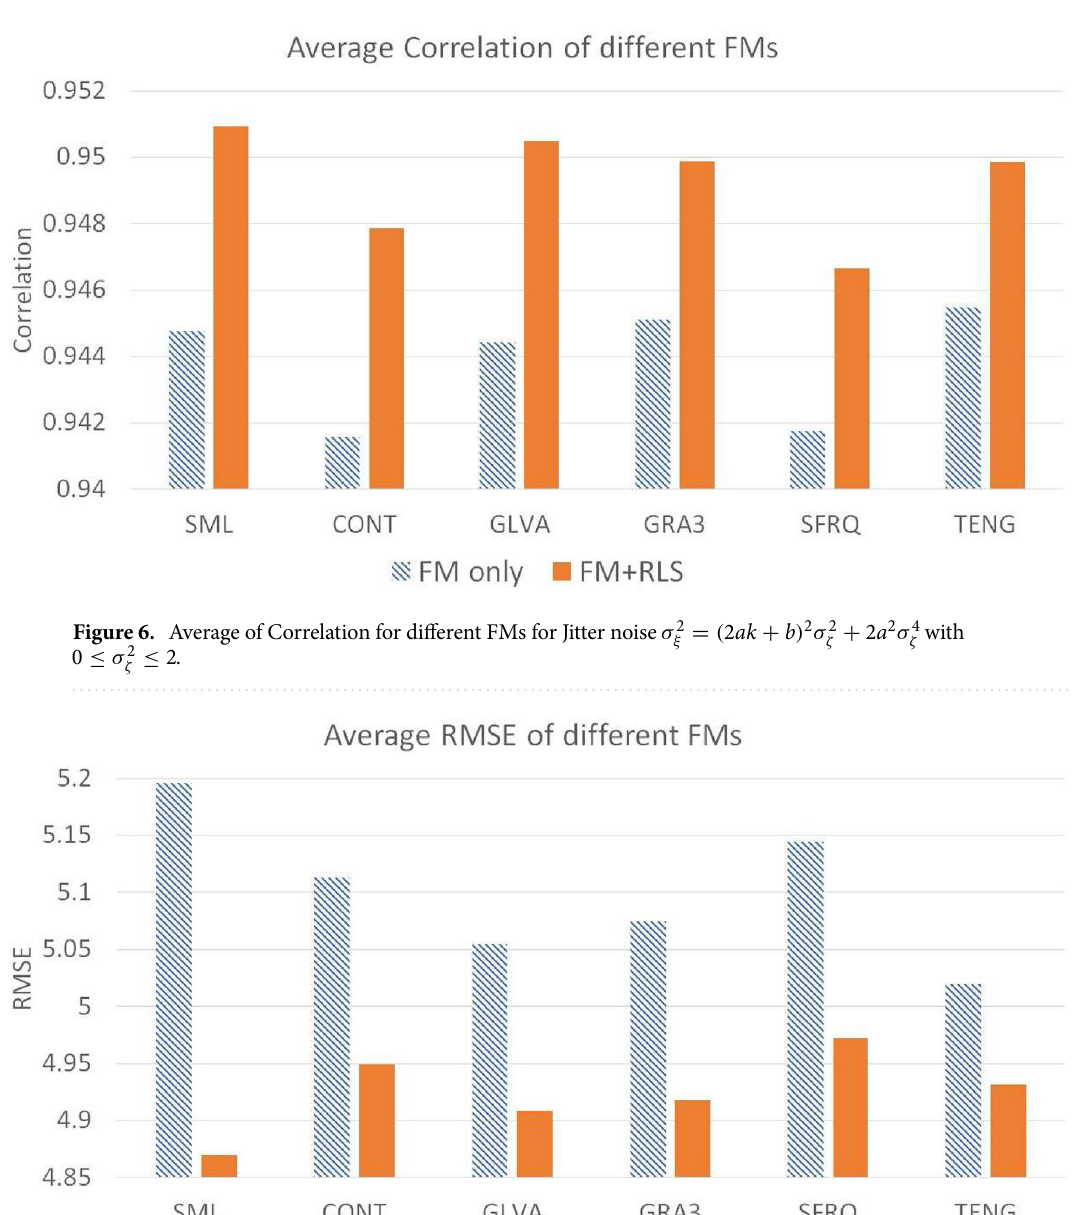
b ) 2 σ 2 2 a 2 σ 4 0 2 ( 2 ak σ 2 ζ + ζ with ζ ≤ = + ≤